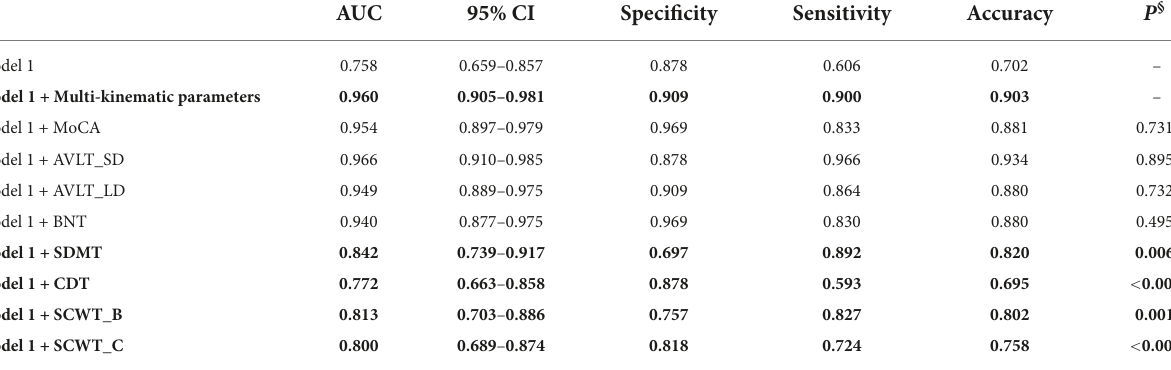
TABLE 4 Diagnostic accuracy of multi-kinematic parameters compared to neuropsychological tests in amnestic mild cognitive impairment